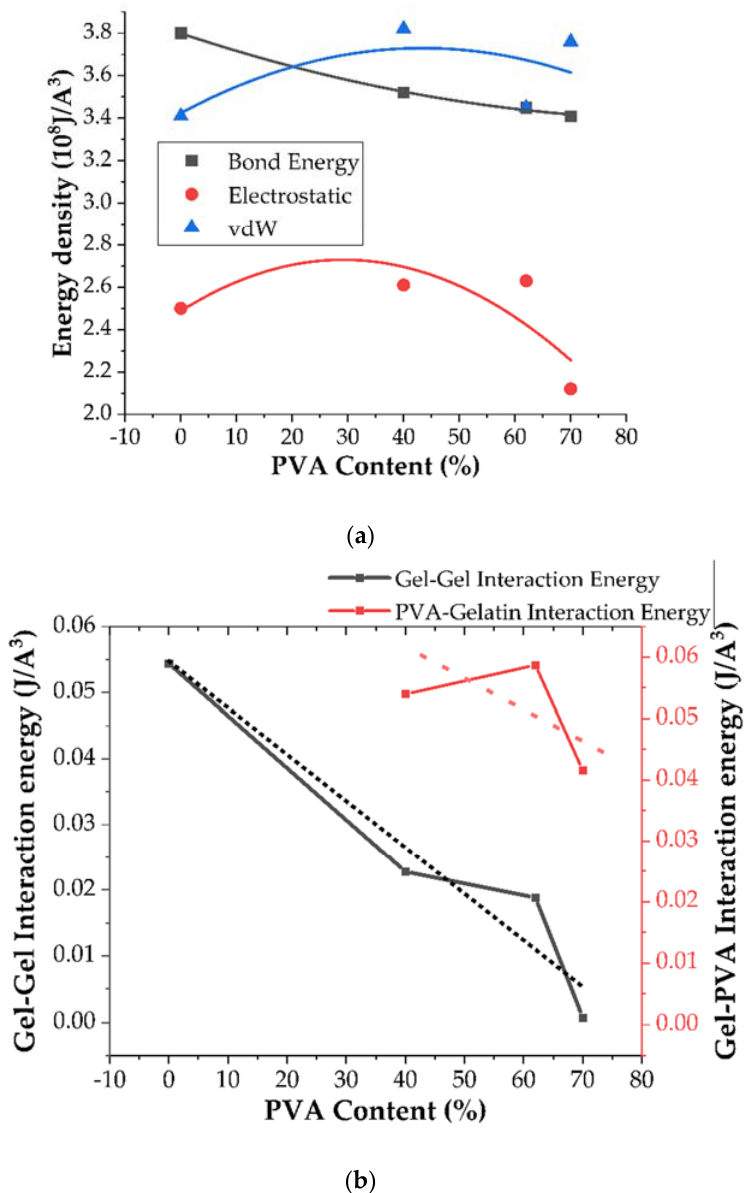
Figure 9. Energy contributions in the gelatin/PVA blends ( a ) and gelatin–gelatin and gelatin–PVA interaction energy ( b ) depending on PVA content.